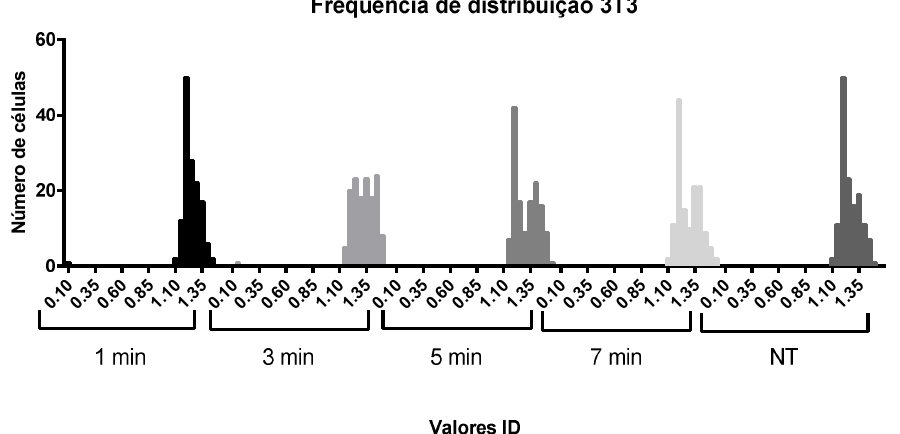
× number of corresponding cells